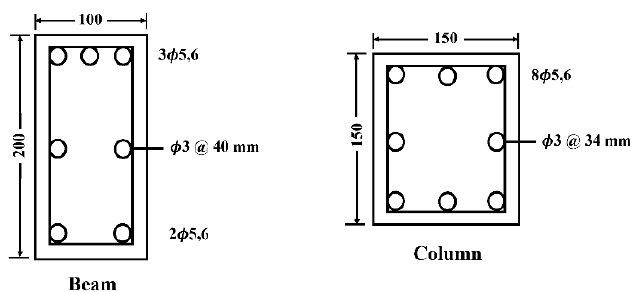
Figure 2. Cross-sections of the beam and column of Karayannis et al. [40]. Table 1. Material properties of Karayannis et al.